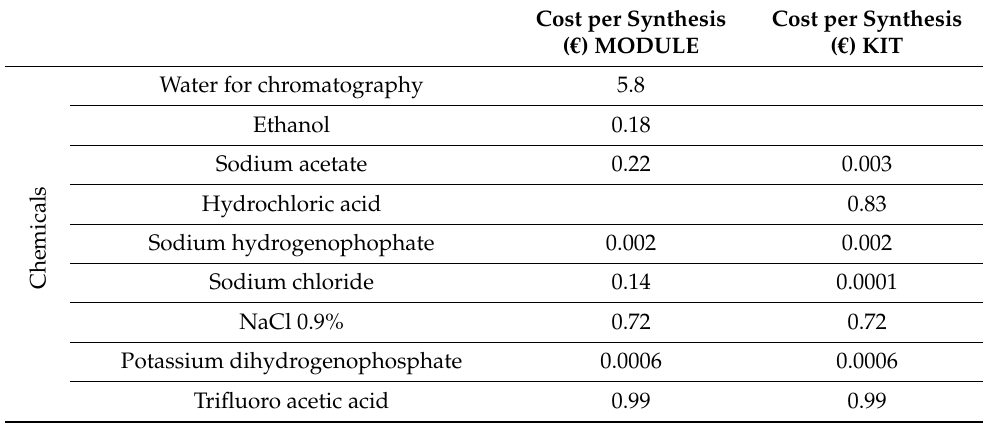
Table 2. Comparison of direct costs for the production of [ 68 Ga]Ga-RM2 by module route or by kit. Cost per